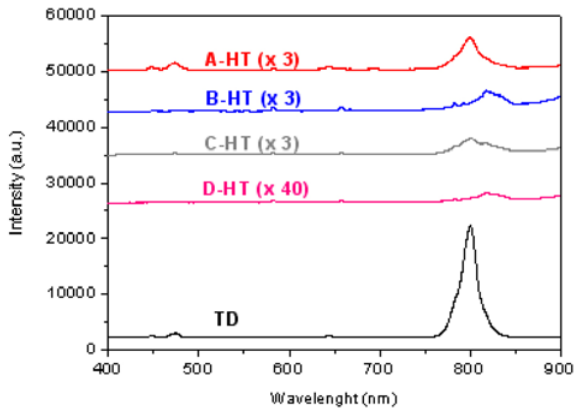
Fig. 5: UC fluorescence spectra of UCNPs in aqueous suspensions. In order to make the weak fluorescence of the samples HT more ea- sily seen, their spectra were multiplied by a factor of 3 (A-HT, B- HT and C-HT) or by a factor of 40